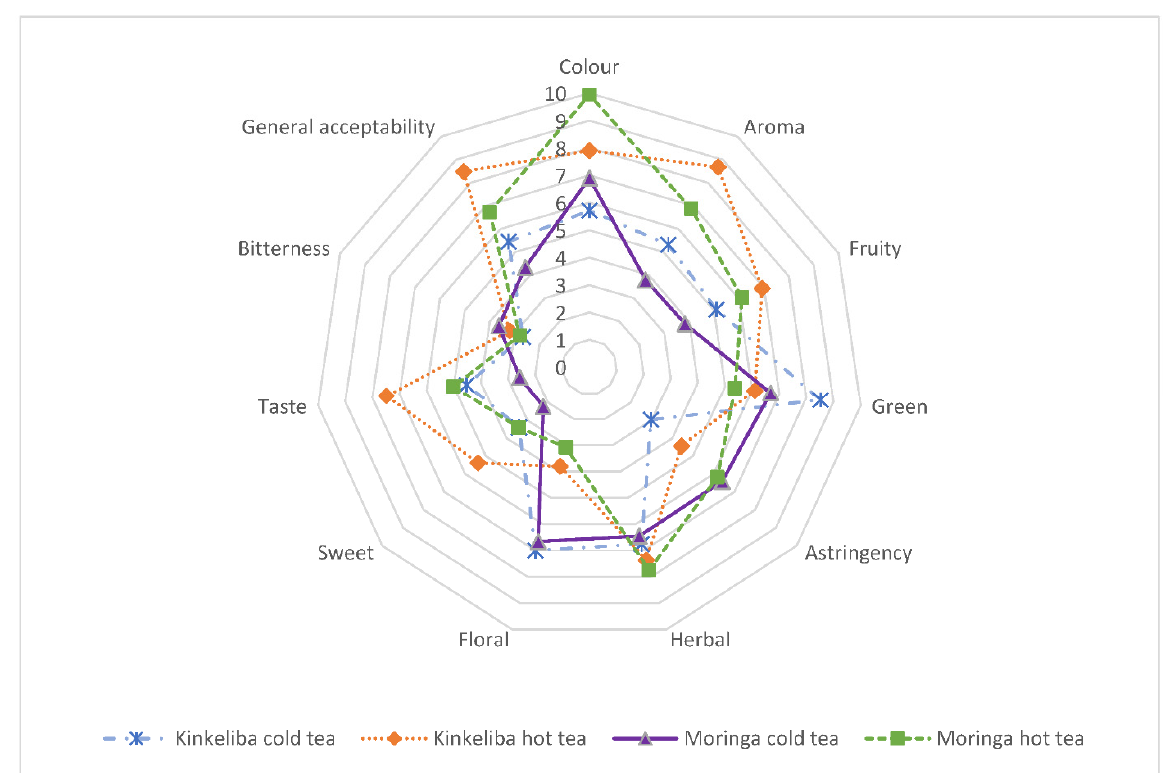
Figure 3. Sensory profiles of Moringa and Kinkeliba tea infusions.